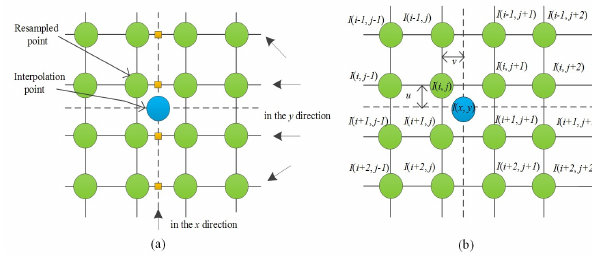
Figure 3. Cubic convolution interpolation. (a) Cubic Convolution interpolation one times in the y direction. (b) 2D Cubic convolution